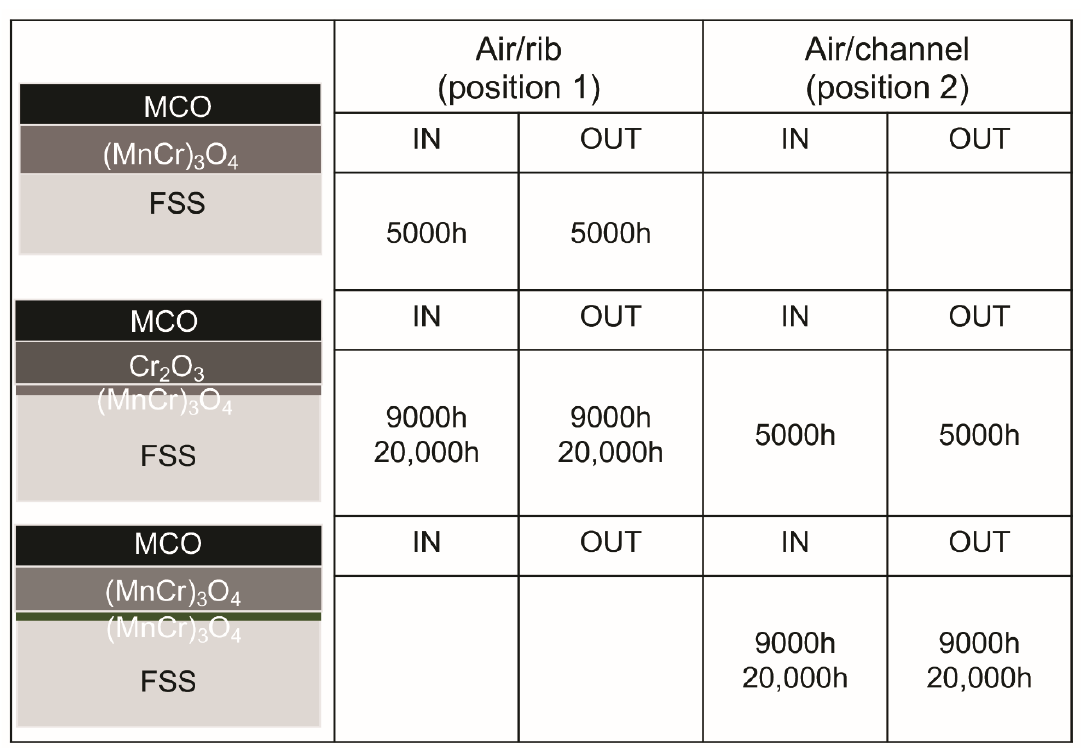
Figure 4. Schematic representation of the TGO compositions found for each operating time; the differences in color of the (Mn,Cr) 3 O 4 are related to the different levels of Mn inside the oxide: grey = Mn content up to 9 at.% and dark green = Mn content from 10 at.%.